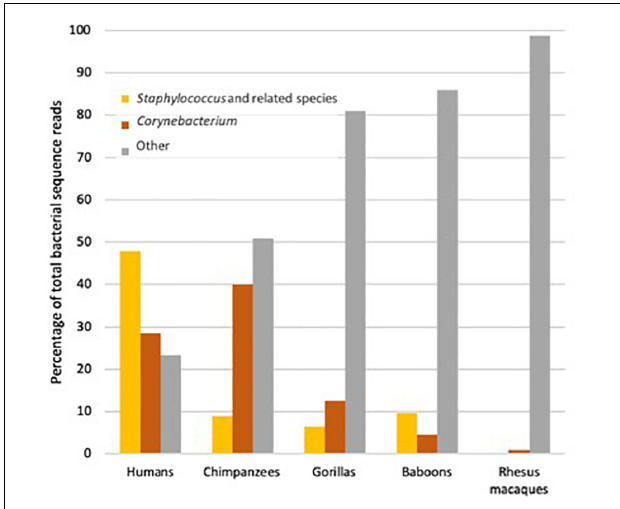
FIGURE 5 | The proportion of bacterial reads in samples of armpits of humans ( Homo sapiens ), chimpanzees ( Pan troglodytes ), gorillas ( Gorilla gorilla ) and two monkey species, Hamadryas baboons ( Papio hamadryas ), and Rhesus macaques ( Macaca mulatta ) that were from species of slow-growing, odor-producing Corynebacterium , weedy fast-growing species of Staphylococcus and relatives or other taxa (Data from Council et al.,